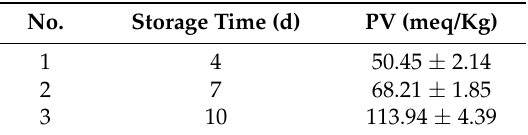
Table 3. Effect of storage time on the peroxide value (PV) of cookies with oligomeric procyanidins from litchi pericarp (LPOPC).